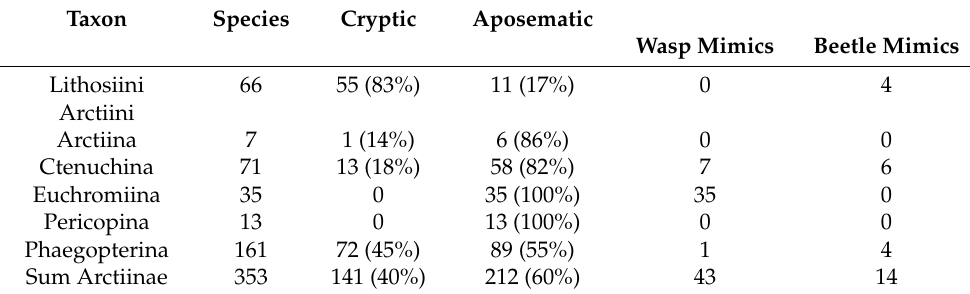
Table 1. Number of species scored as aposematic, as hymenopteran mimic, as beetle mimic and as cryptic. Percentages represent the incidence of aposematism and crypsis within each taxon. Taxon Species Cryptic Aposematic Wasp Mimics Beetle Mimics Lithosiini 66 55 (83%) 11 (17%) 0 4 Arctiini Arctiina 7 1 (14%) 6 (86%) 0 0 Ctenuchina 71 13 (18%) 58 (82%) 7 6 Euchromiina 35 0 35 (100%) 35 0 Pericopina 13 0 13 (100%) 0 0 Phaegopterina 161 72 (45%) 89 (55%) 1 4 Sum Arctiinae 353 141 (40%) 212 (60%) 43